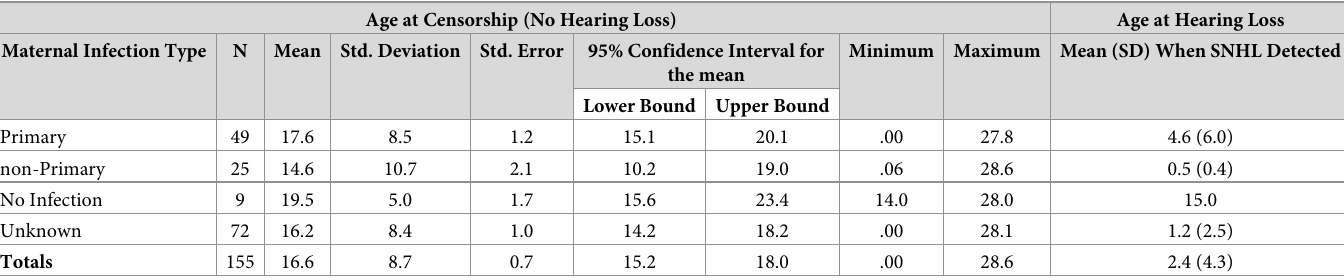
Table 5. Age at censorship or first sensorineural hearing loss, by maternal infection